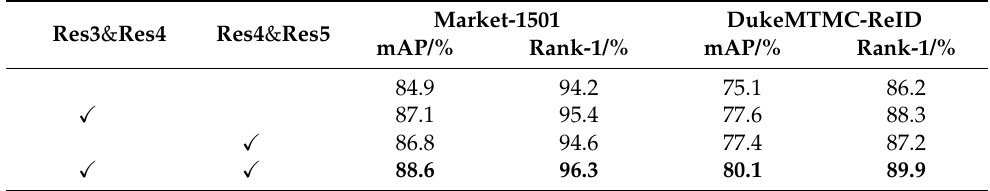
Table 3. Comparative experiment of feature fusion module.